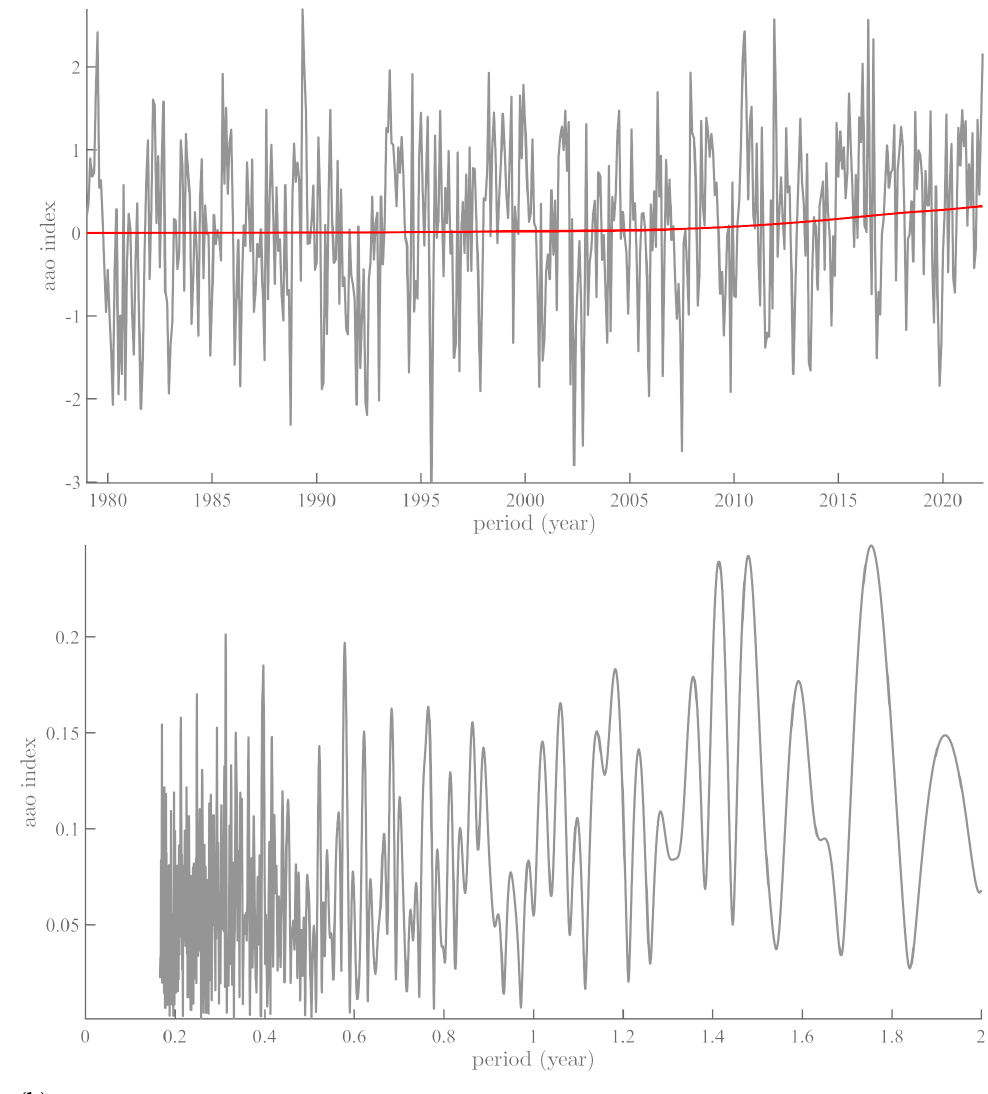
Figure 10. AO and AAO Indices: ( a ) AO Index with its mean (red) and spectrum (lower curve); ( b ) AAO Index with its mean (red) and spectrum (lower